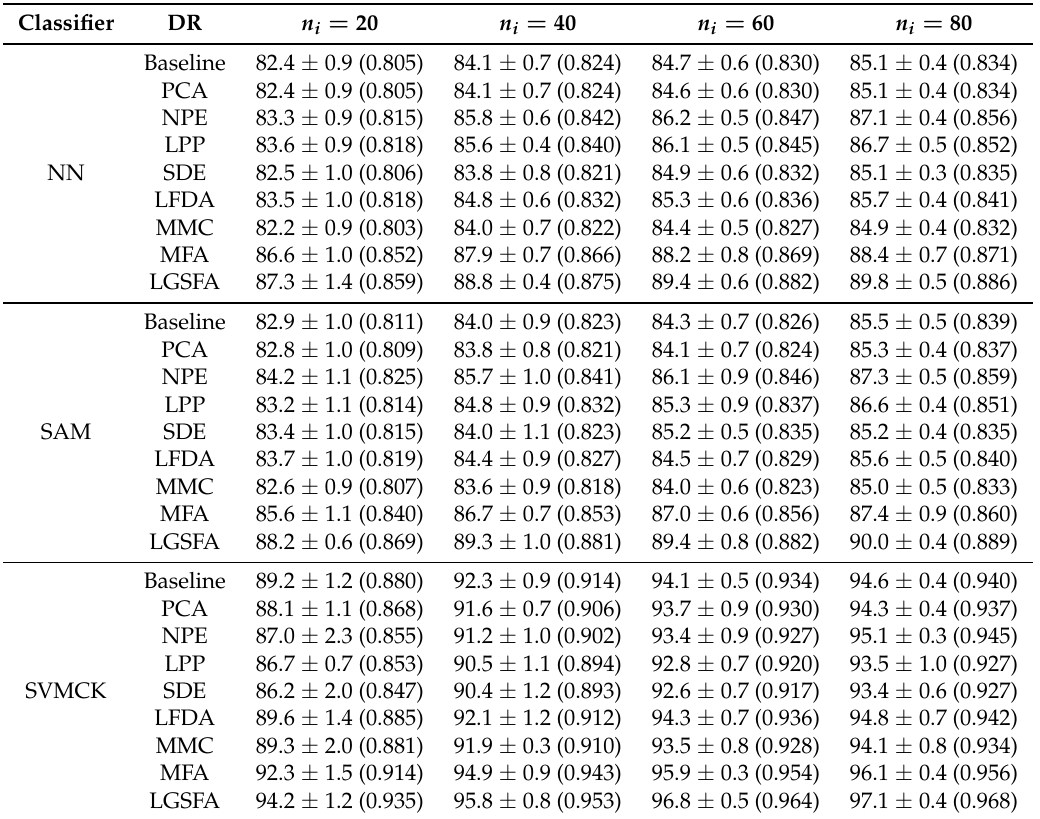
Table 1. Classification results with different numbers of training samples on the Salinas data set (OA ± std (%)